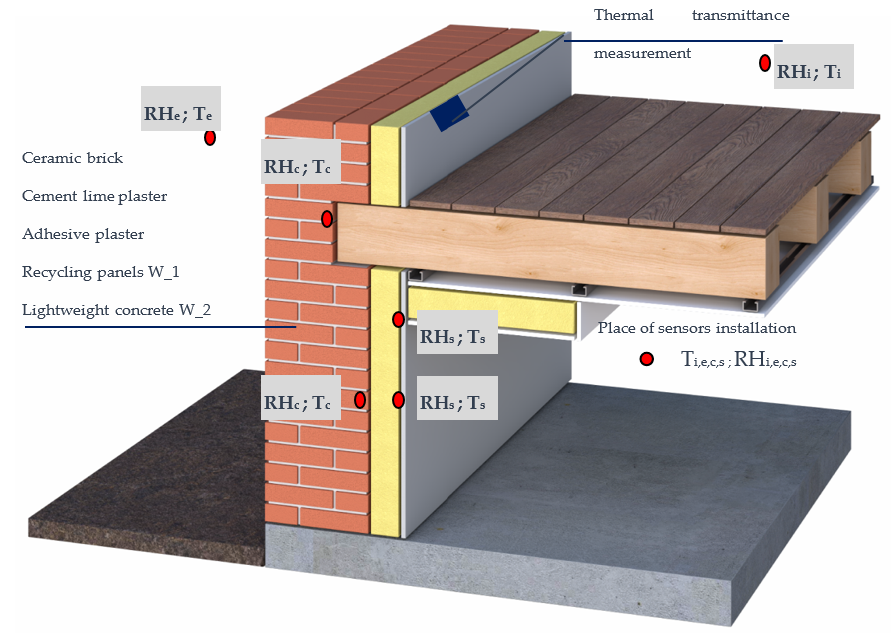
Figure 7. Diagram of the test stand with the arrangement of sensors. (notation: s-surface, i-inside; e-external; e-external; c-contact)